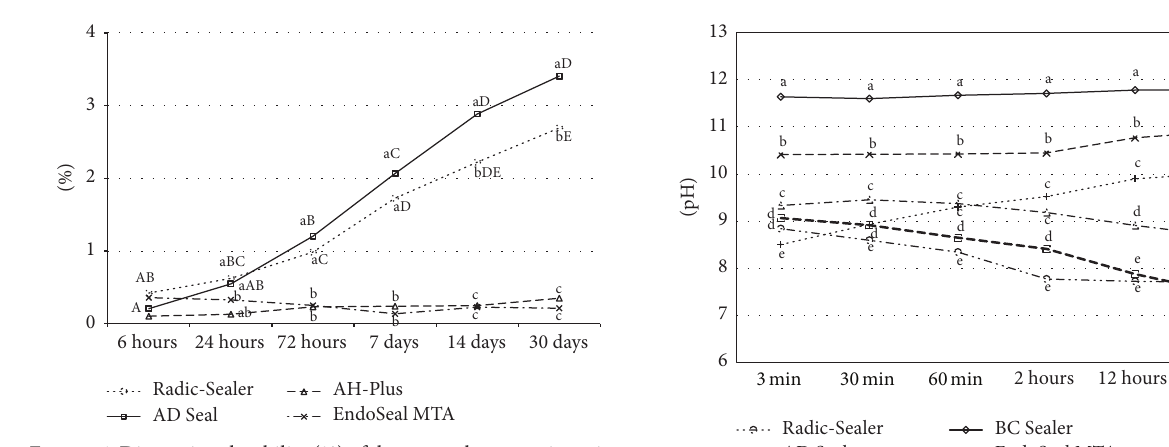
Figure4:Dimensionalstability(%)ofthetestsealersatvarioustime